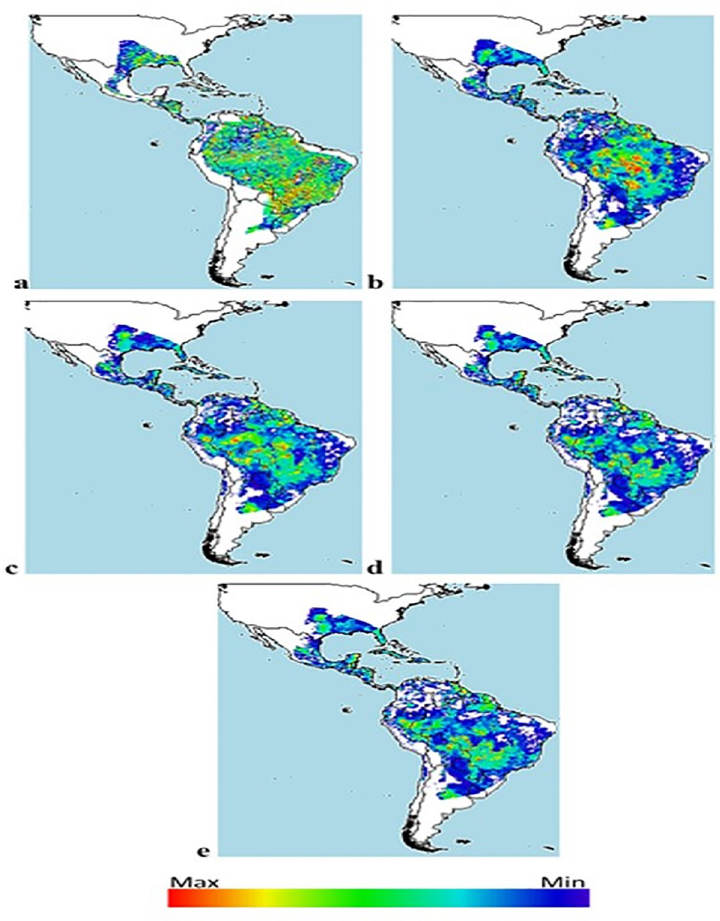
Fig 8. Distribution of Diatraea spp. in the Western Hemisphere under different climate change (BCC-CSM1-1) and carbon concentration projections over 50 years. a) current condition, b) rcp26, c) rcp45, d) rcp60, e) rcp85. Color indicates maximum or minimum presence in a likely niche and under favorable